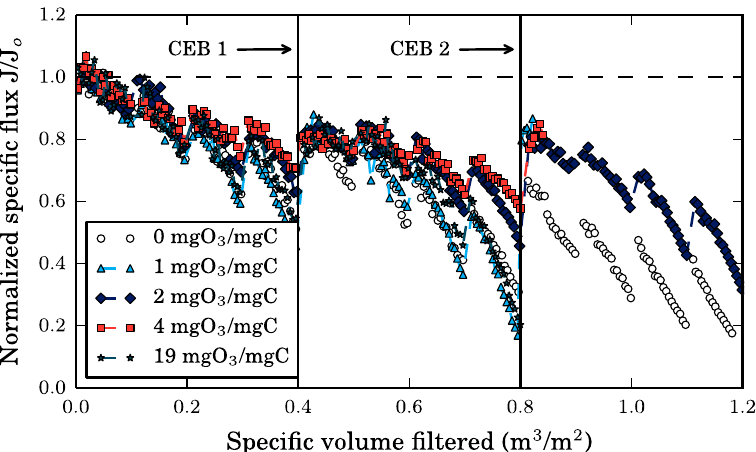
Figure 9. Impact of ozone CEB dosage on the membrane’s specific flux decrease during constant flux, dead-end filtration (200 LMH) of cyanobacteria-spiked surface water (Cyano-SW). The horizontal dashed line indicates the clean membrane flux. The 19 mgO 3 /mgC experiment was stopped at 0.8 m 3 /m 2 .